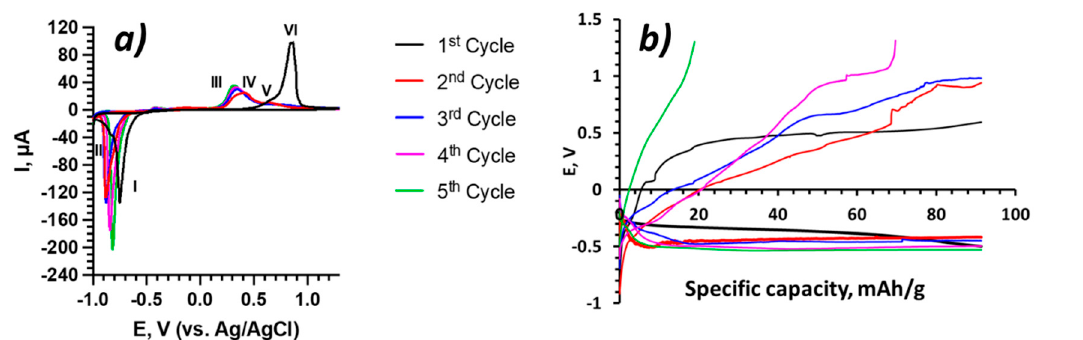
Figure 3. ( a ) Bi 2 Se 3 thin films CVs at scan rate 0.25 mVs − 1 and ( b ) charge–discharge curves at 90 mA/g in − 1.0 ÷ 1.3 V vs. Ag/AgCl potential range.